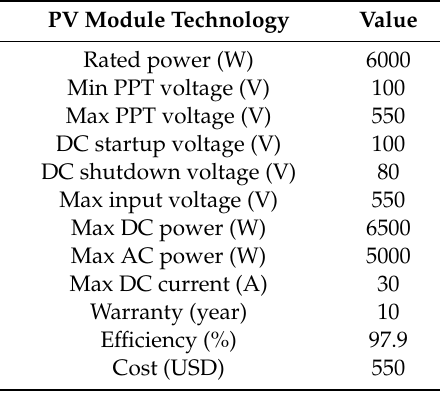
Table 3. Technical specification of the selected inverter.